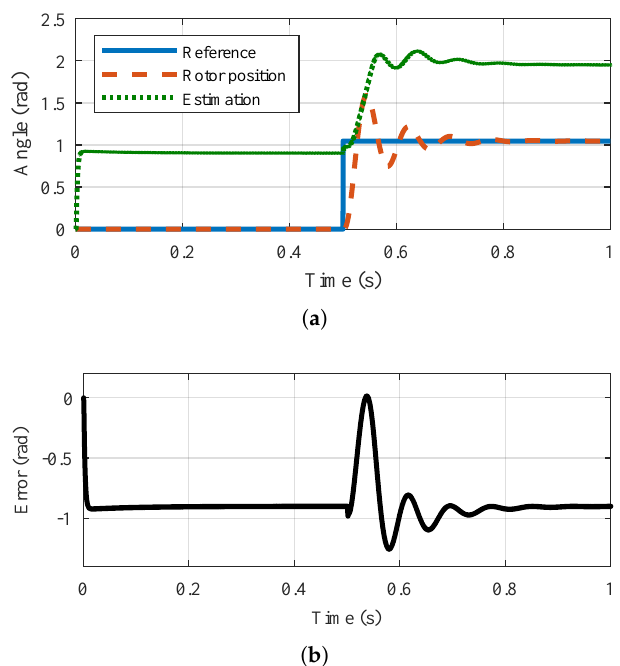
Figure 4. Simulation results using the traditional demodulation scheme. ( a ) Reference angle (blue solid), rotor position (dashed orange), estimated angle (dotted green). ( b ) Estimation error.